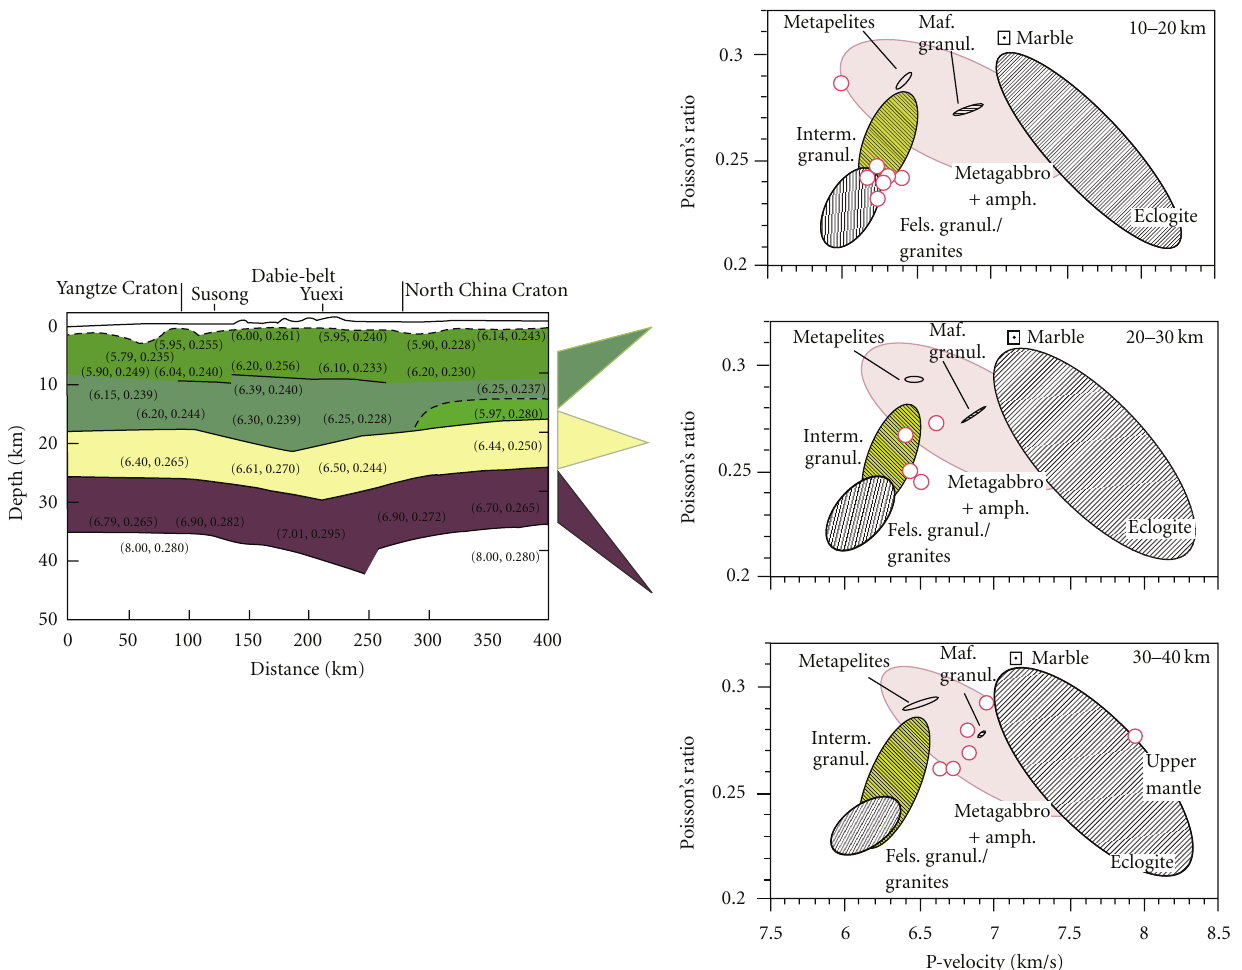
Figure 6: Comparison of ranges of experimentally derived in situ velocities and Poisson’s ratios for UHP rocks for various depth of the four-layer crustal structure at Dabie [5] with respective seismic refraction data [26] (red